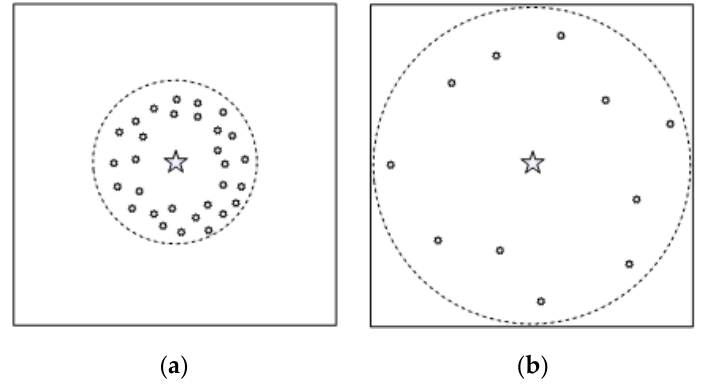
Figure 1. Two kinds of different phenomenon after fireworks explode. ( a ) Good fireworks explode; ( b ) bad fireworks explode.